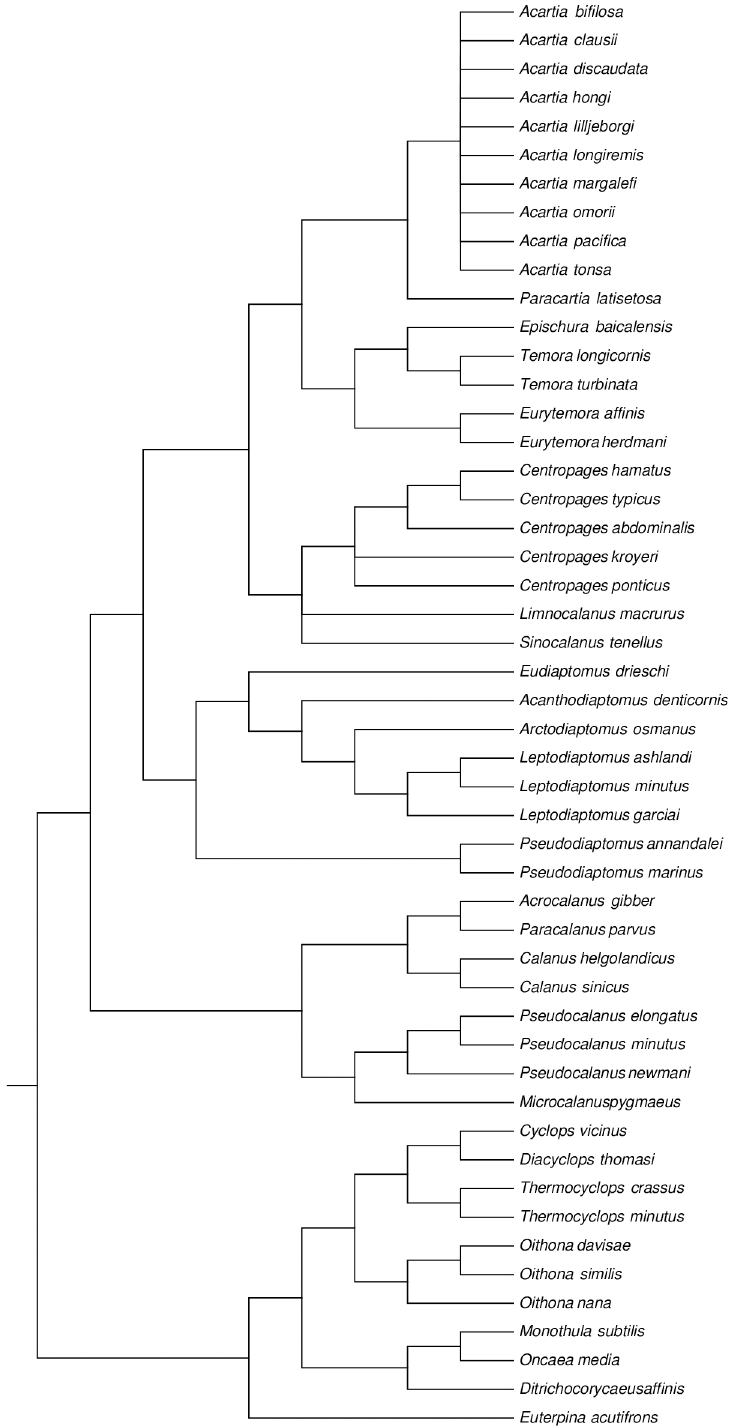
Fig 1. Phylogenetic tree of the 85 copepod species included in the global analysis of phenotypic plasticity of female size. This phylogeny was assembled using diverse sources and was used to perform phylogenetically informed